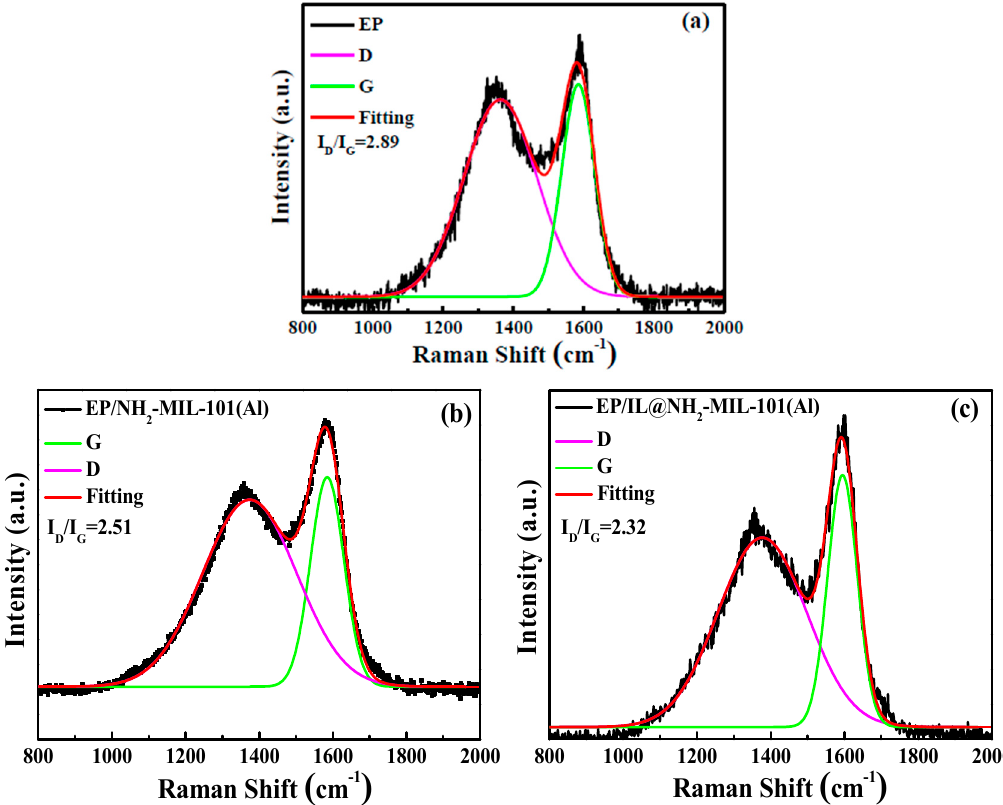
Figure 11. Raman spectra of char residues of EP ( a ), EP / NH 2 -MIL-101(Al) ( b ), and EP / IL@NH 2 -MIL-101(Al) ( c ) after the cone calorimeter test.